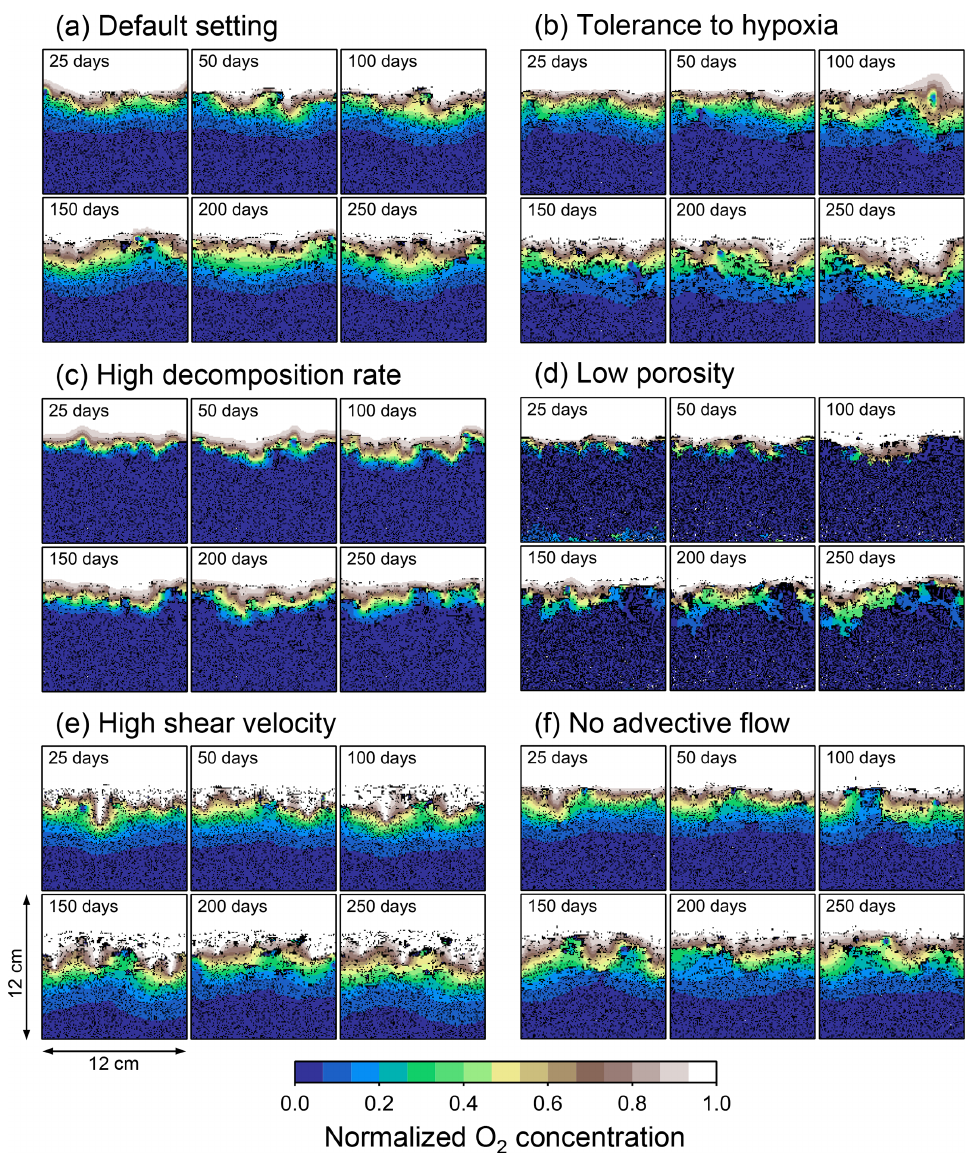
Figure 4. Time evolution of oxygen profiles calculated for 1-year simulations by eLABS. Six different simulations were conducted (Sect. 3.1): (a) with the default settings, (b) assuming organisms have tolerance to oxygen-depleted conditions but otherwise default settings, (c) with 10 × higher rate for aerobic decomposition of organic matter but otherwise default settings, (d) with 0.6 of porosity but otherwise de- fault settings, (e) with 10 × higher shear velocity but otherwise default settings, and (f) without the deterministic water flow calculation with otherwise default settings. Shown are the profiles of oxygen concentration normalized to the constant boundary value (2 . 2 × 10 − 4 molL − 1 ) at the top layer of the grid at 25, 50, 100, 150, 200, and 250 model days from the start of the